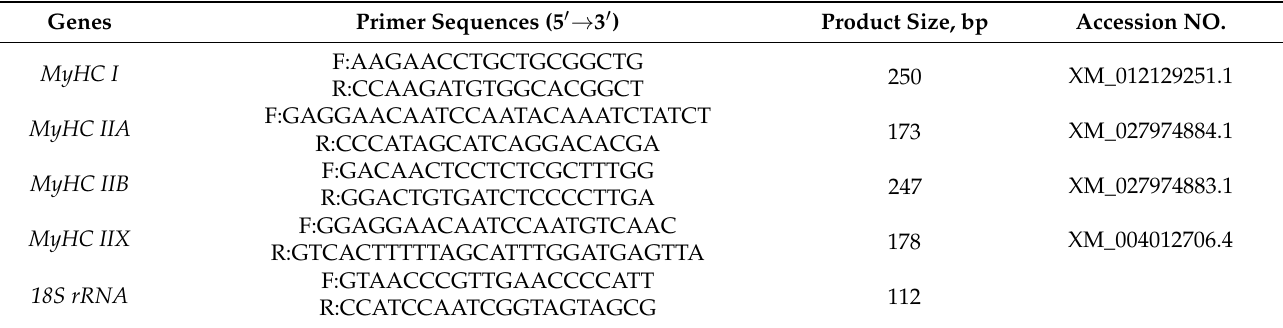
Table 1. The primers used for real-time PCR